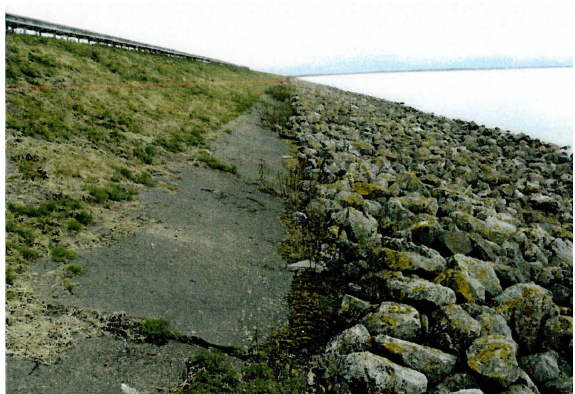
Figure 1. Rock armour on the low part of the seaward slope (from